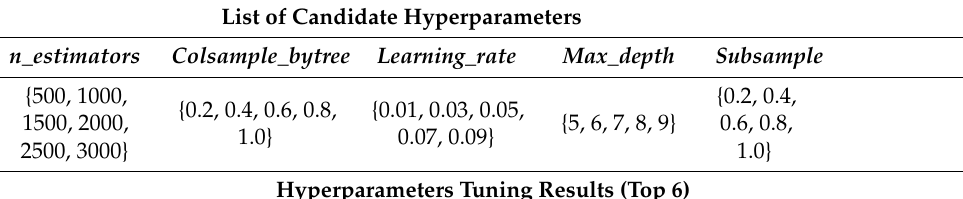
Table A2. The list of candidate parameters and parameters tuning results for finding the optimal parameter set in